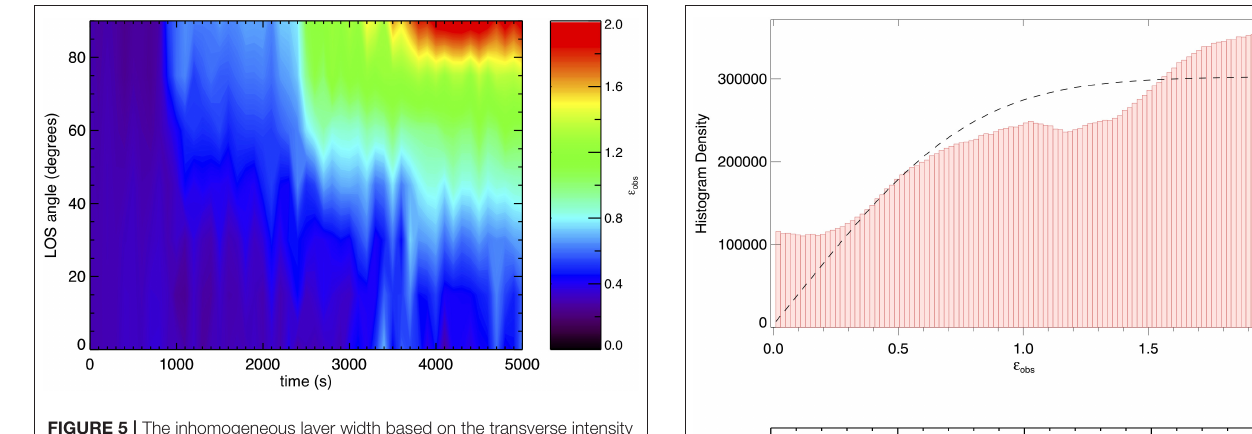
FIGURE 5 | The inhomogeneous layer width based on the transverse intensity profile of the coronal loop in our numerical simulation. Near the start of the simulation the initial value of 0.3 is measured for all LOS angles, but at later times the observed value increases.